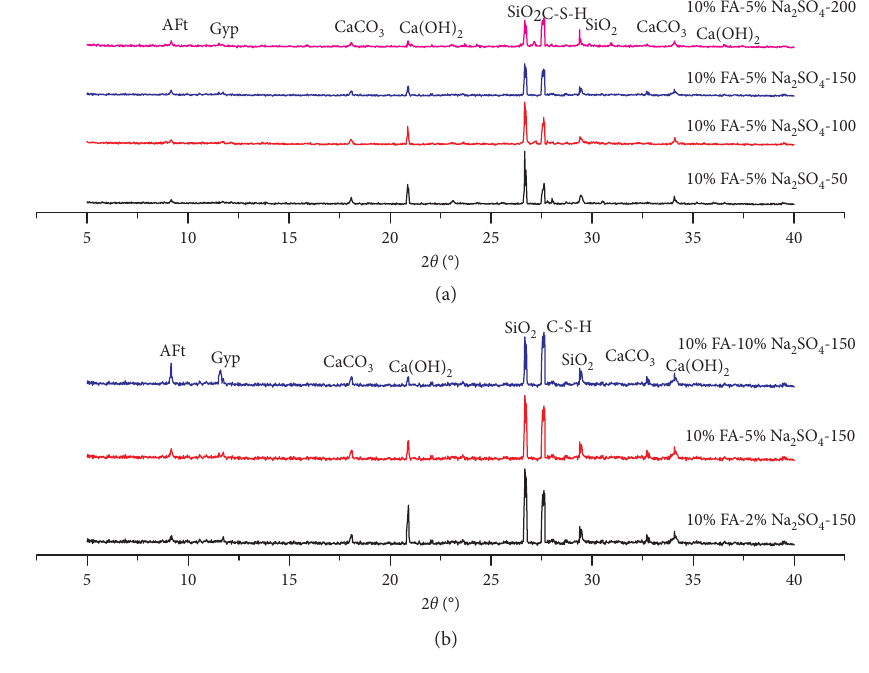
Figure 9: XRD analysis of concrete. Table 6: Pore characteristics of specimens after coupling